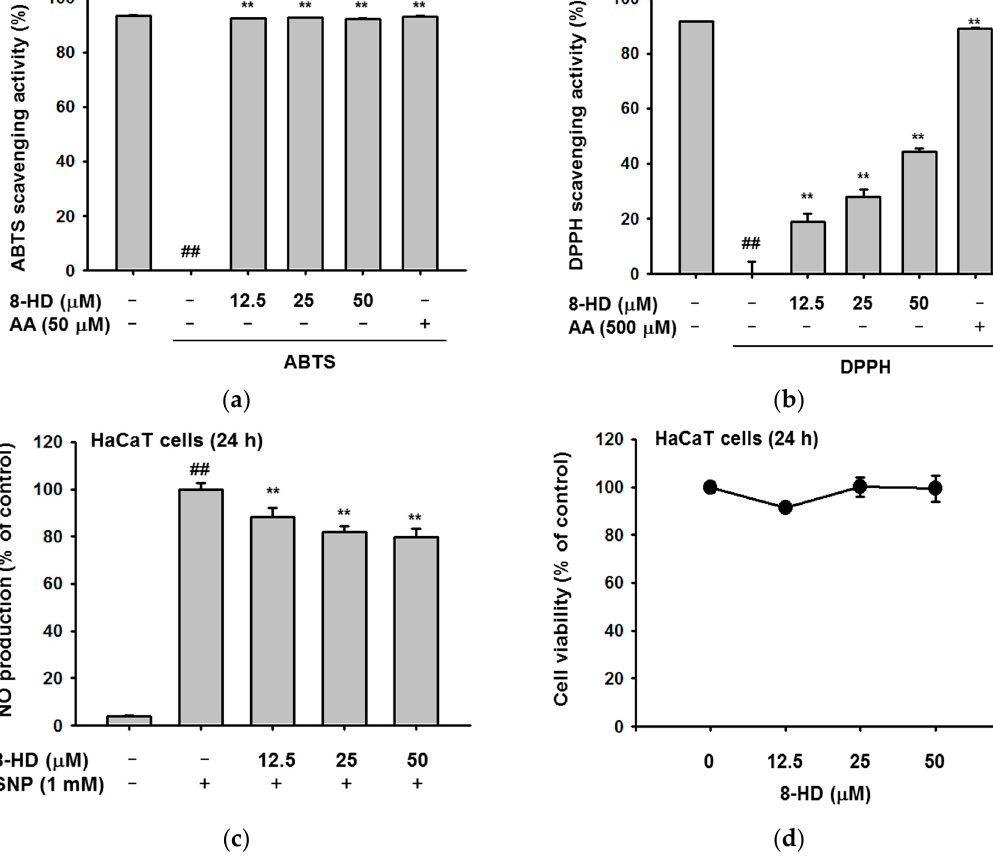
Figure 2. The antioxidant effects of 8-HD. ( a ) 8-HD was incubated with ABTS solution for 30 min at 37 °C. The absorbance was measured by spectrophotometry. ( b ) DPPH and 8-HD were mixed for 30 min at 37 °C. The absorbance at 517 nm was measured. ( c ) RAW264.7 cells were pre-treated with 8-HD for 30 min and then treated with SNP (1 mM) for 24 h. SNP-induced NO production was measured by Griess assays. ( d ) HaCaT cells were treated with 8-HD for 24 h. Cell viability was examined by MTT assays. ## p < 0.01 versus a normal group (untreated group), ** p < 0.01 versus a control group (induced group). AA: ascorbic acid, SNP: sodium nitroprusside.